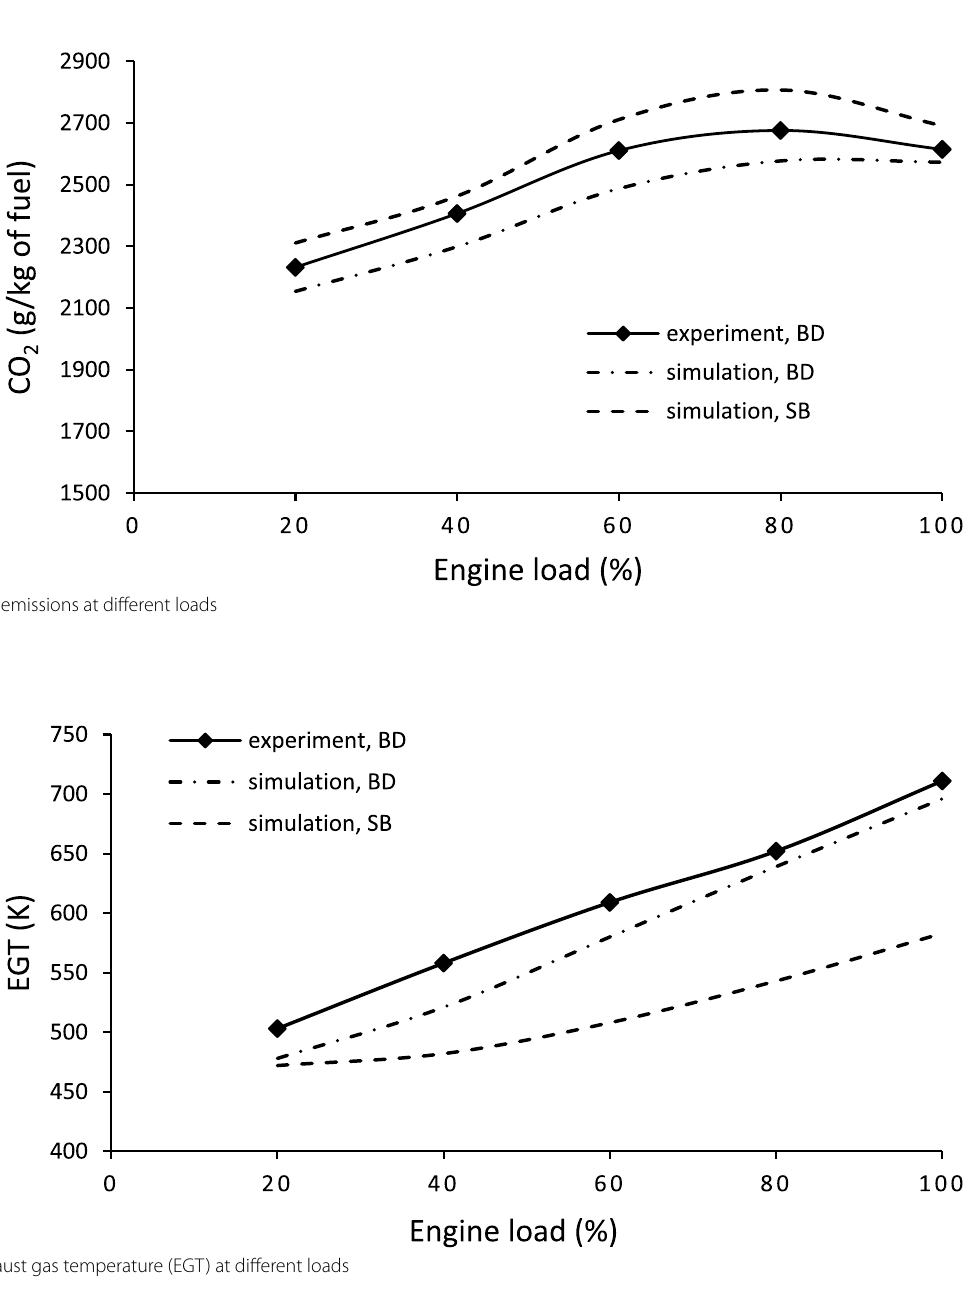
Fig. 17 Exhaust gas temperature (EGT) at different loads